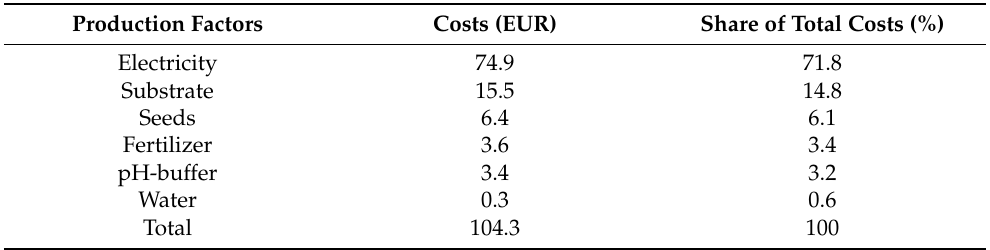
Table 12. Economical assessment (renewable energy mix): production factors, costs and their relative contribution to the total costs.